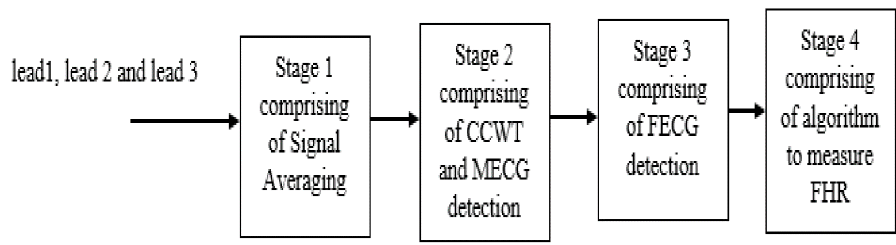
Figure 9. The proposed 4-stage fetal heart rate (FHR) extraction method [7].